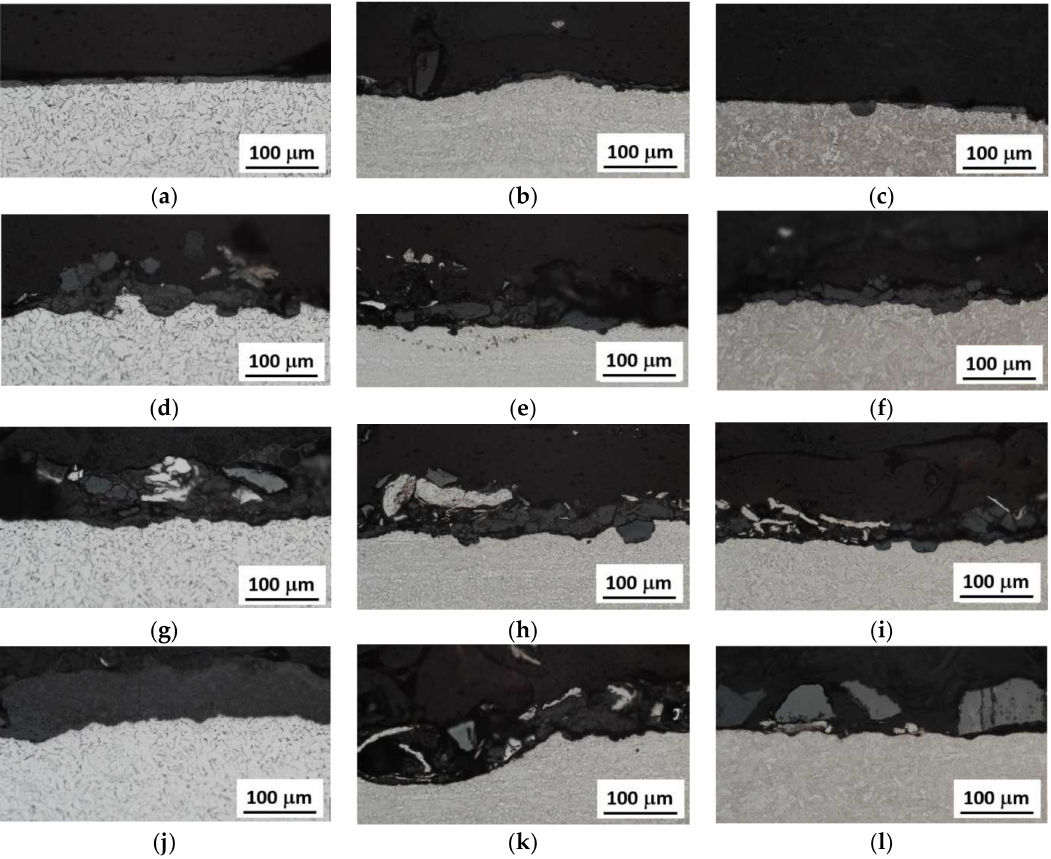
Figure 3. Cross sectional metallographic images of corroded, RD. ( a ) S235—1 day, ( b ) MC700—1 day, ( c ) MC1100—1 day,